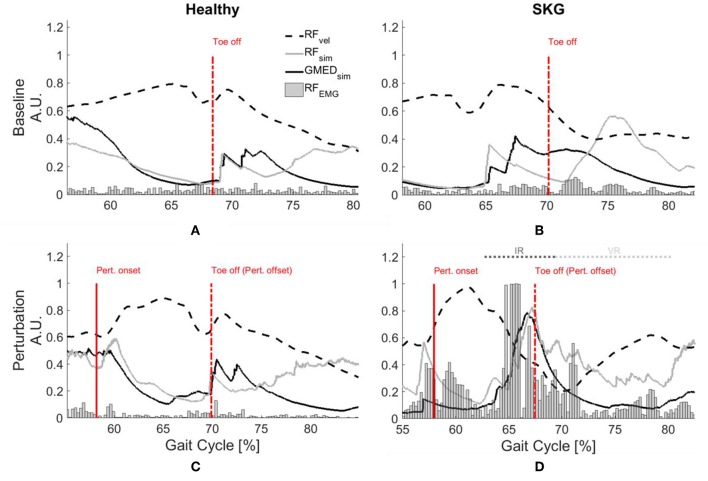
GMed and RF activations are increased with RF stretch velocity in stroke. Rectified RF EMG, simulated RF fiber stretch velocity and muscle activations of RF and GMed for a representative healthy control (left) and individual with SKG (right) during baseline (A,B) and with perturbation (C,D). Each gait interval begins in pre-swing (55–60%gait cycle) and continues until late-swing (80–85% gait cycle). The RF fiber velocities were normalized with respect to the maximum of the demonstrated steps and RF EMG measures are normalized with respect the maximum values throughout the gait cycles of the corresponding subjects. The RF fiber stretch velocity values are increased for both healthy and SKG individuals with the perturbation. However, the raw RF EMG measures and simulated GMed and RF activity only increased in the individual with SKG following peak RF fiber velocity. This is indicative of an abnormal coupling pattern between RF and GMed in post-stroke SKG. The activations of RF and GMed are increased during the involuntary response (IR) period (<120 ms).